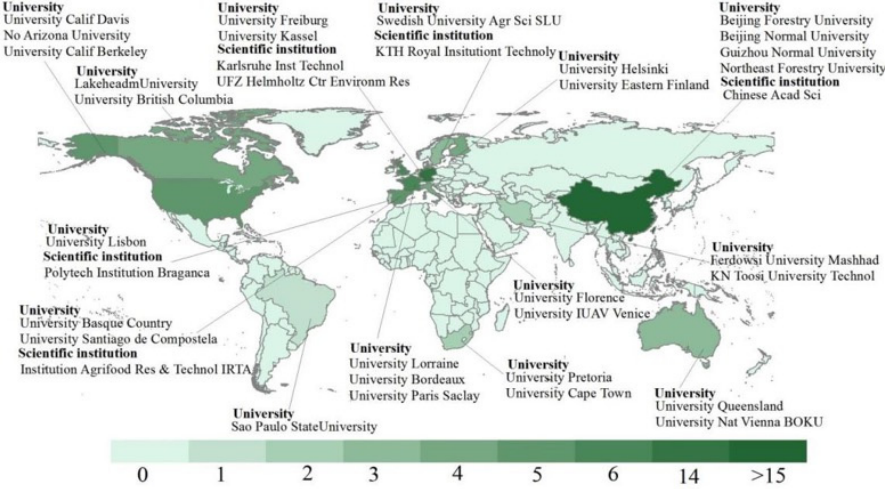
Figure 3. Distribution of countries and institutions studied in the literature. The different color bands and numbers at the bottom indicate the number of publications; the darker green the color, the higher the number of publications.